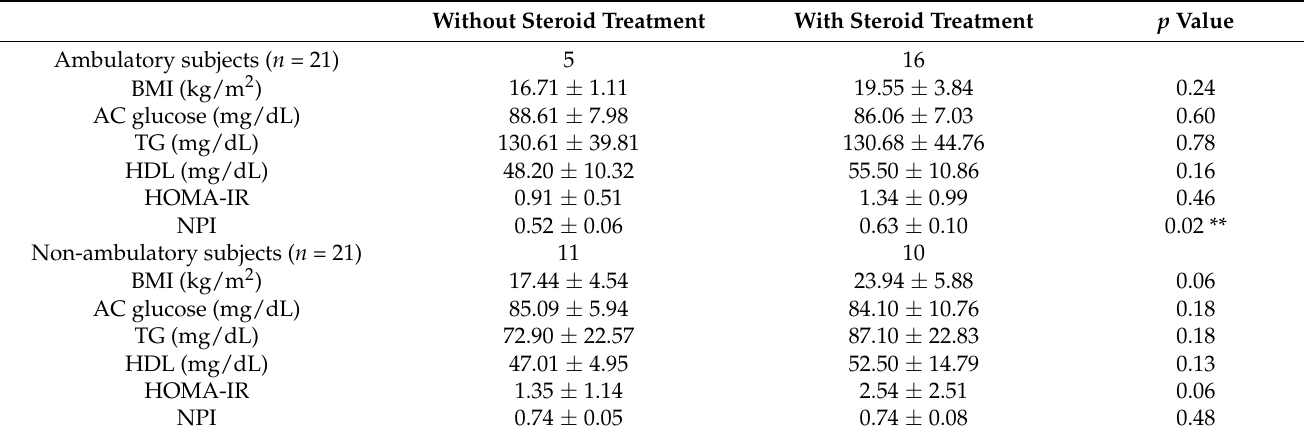
Table 4. Comparisons of anthropometric and biochemical parameters between the groups without and with steroid treatment. The significant differences were found in NPI of ambulatory patients. Without Steroid